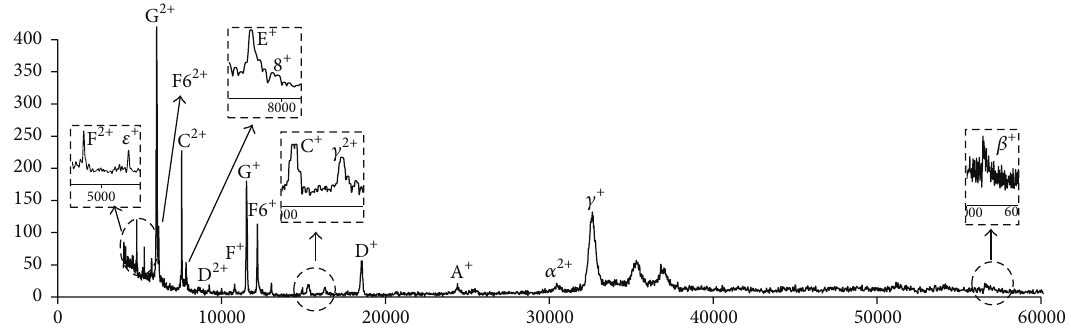
Figure 4: MALDI-TOF-MS of integral protein of mitochondria complex V.